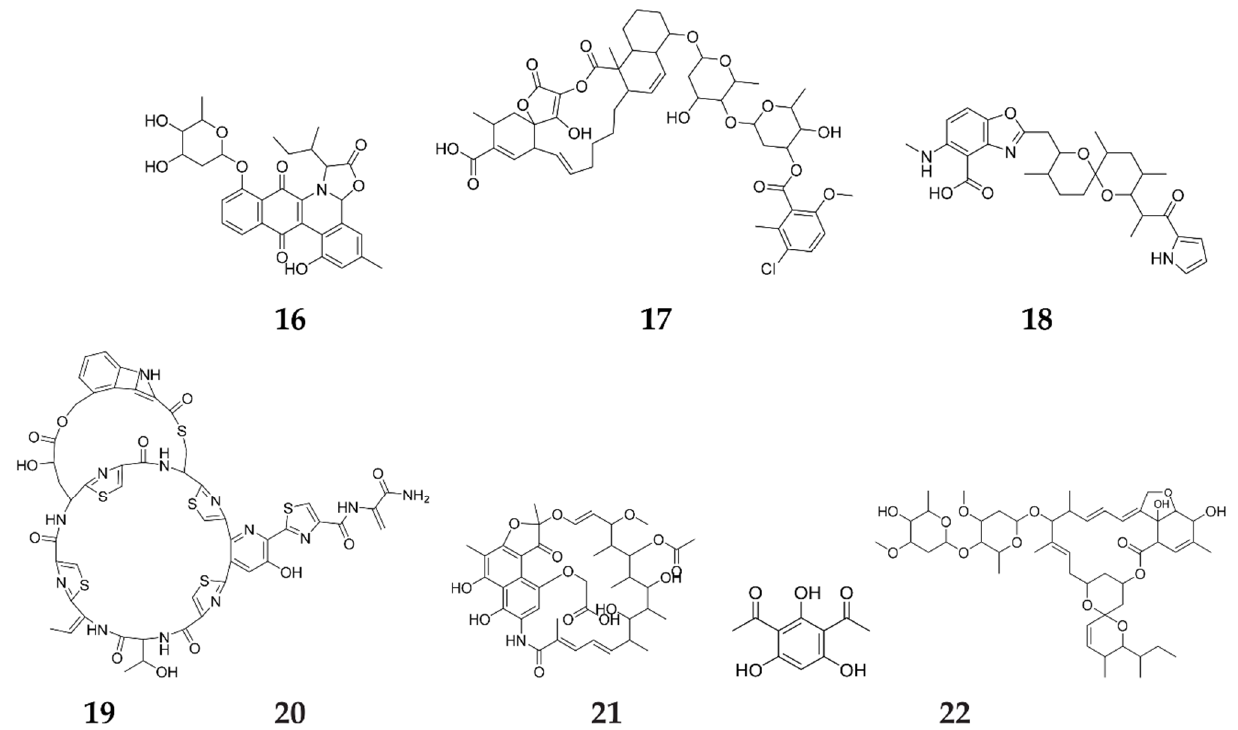
Figure 3. Secondary metabolites elicited by autoregulation from the same